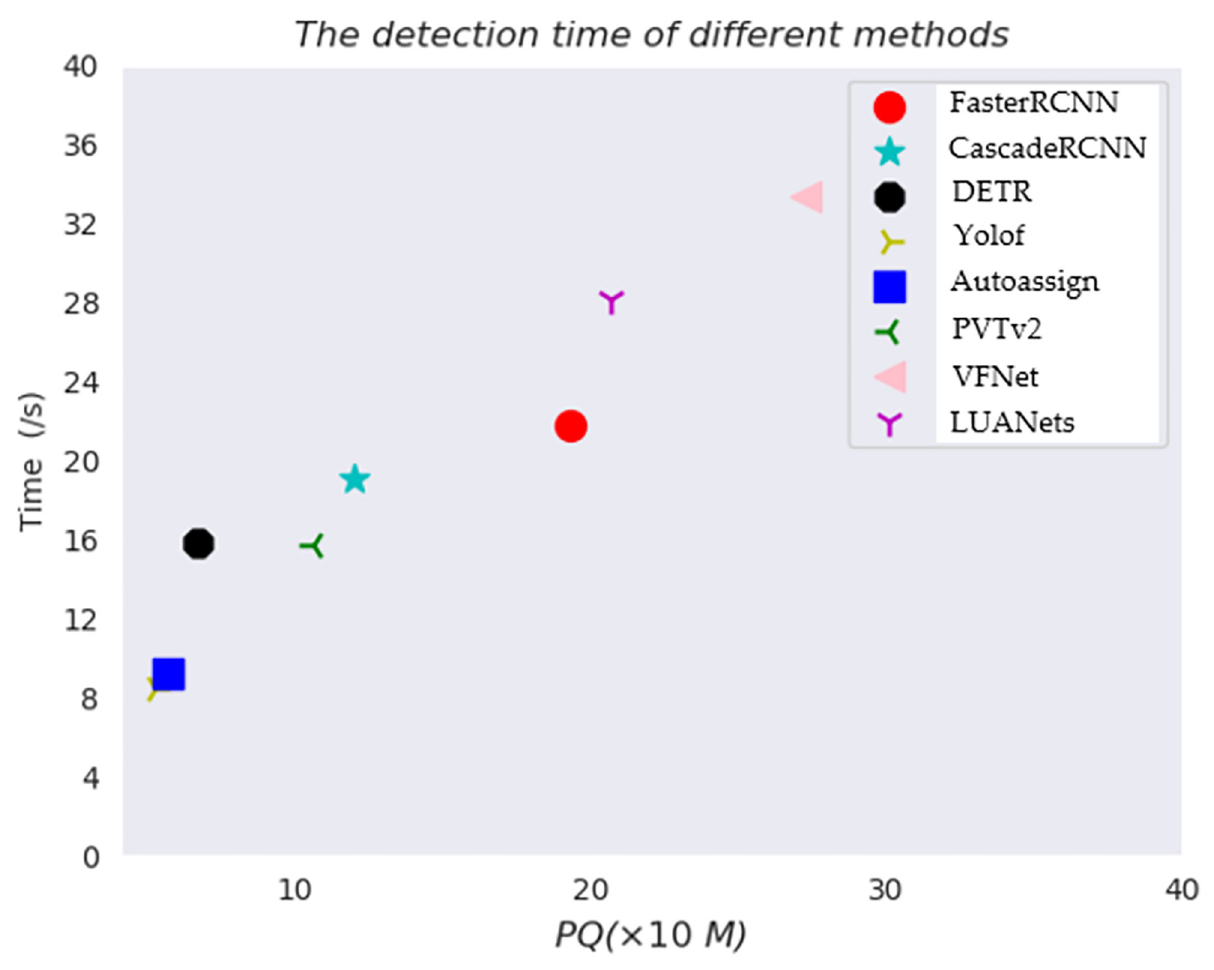
Fig 3. Detection efficiency of the different models. M indicates that the model parameter is megabytes, and s indicates the time it takes for every 100 images to be detected.